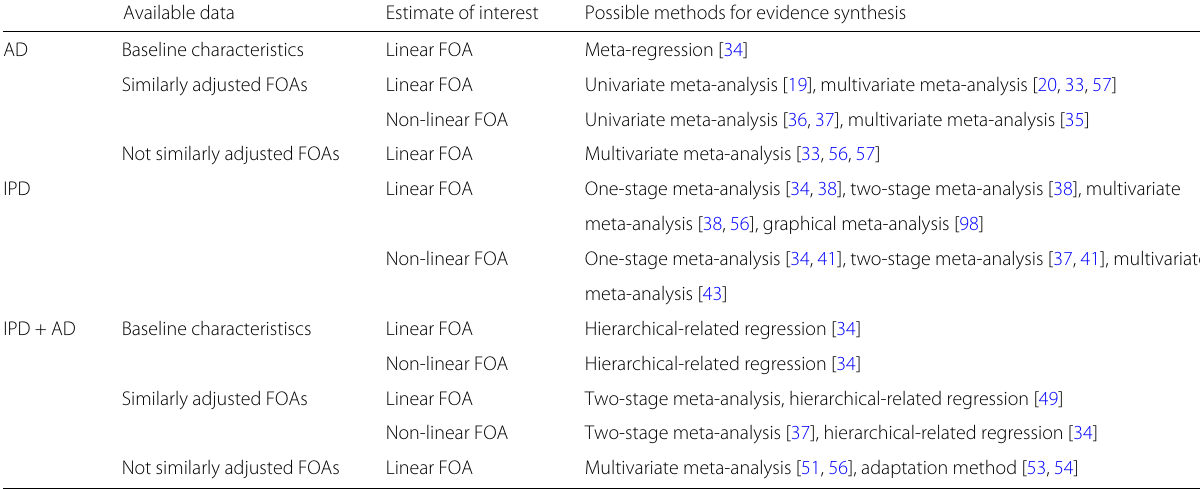
Table 1 Available methods for quantitative synthesis in prognostic factor research Available